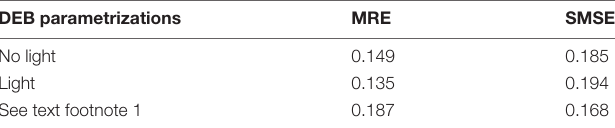
TABLE 1 | Estimated mean relative errors.